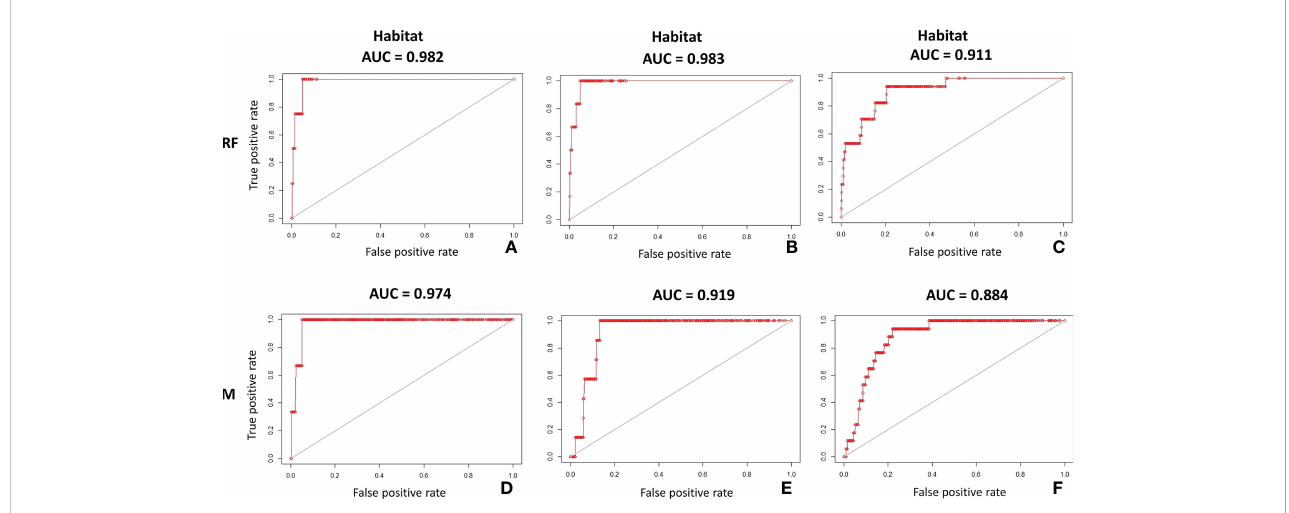
FIGURE 5 AUCplots ontestdatasetshowingthe accuracy of RandomForest (RF)andMaxEnt (M)inpredictingthepotentialdistributionof coralligenous: (A) RandomForest AUContestdatasetof habitatA; (B) RandomForestAUContestdatasetofhabitatB; (C) RandomForest AUCon test datasetof habitat C; (D) MaxEntAUContest datasetof habitat A; (E) MaxEntAUContestdataset of habitatB; (F) MaxEnt AUCon test datasetof habitat